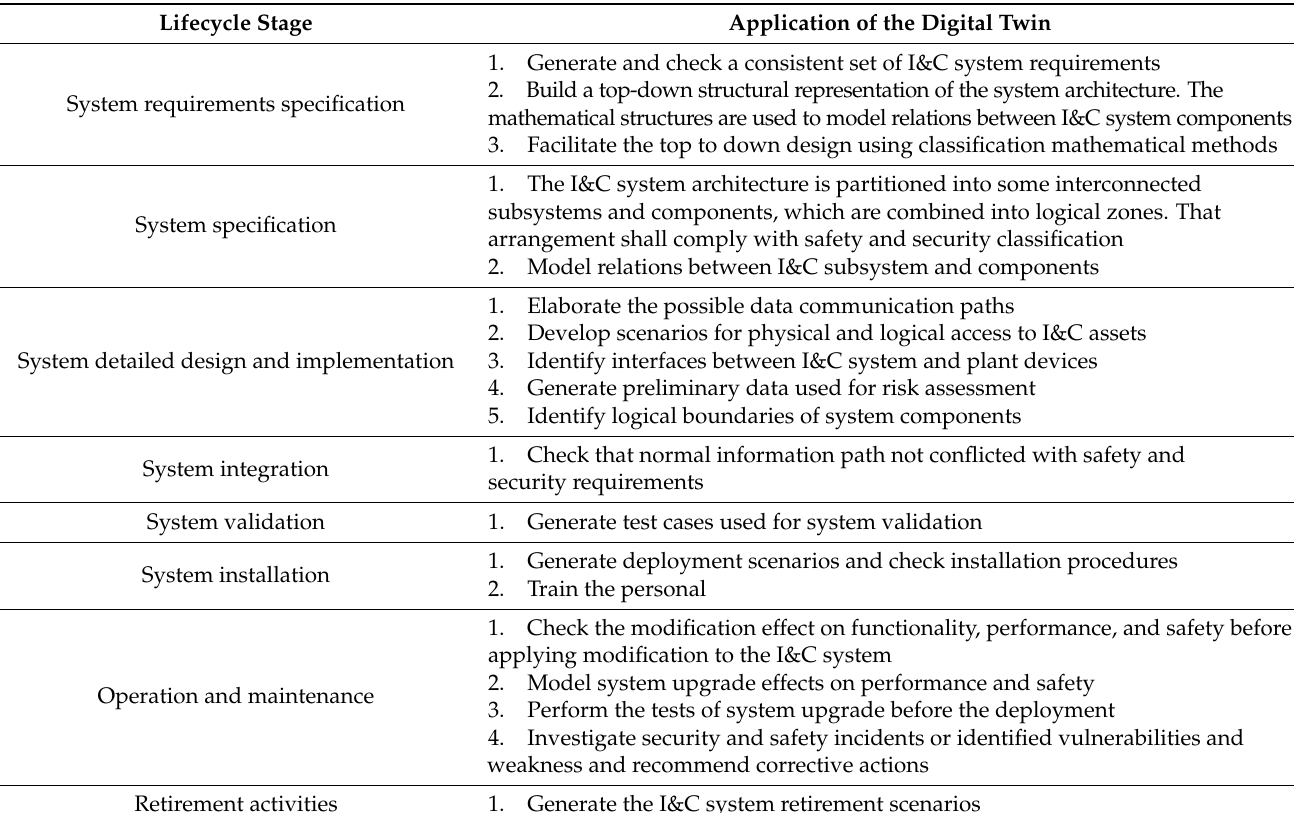
Table 3. The I&C lifecycle stages and corresponding scenarios of using the digital